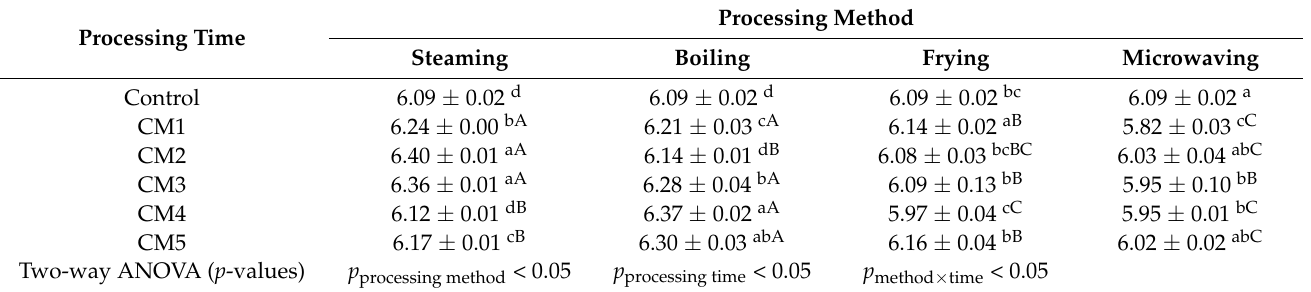
Table 2. Comparison of pH values of camel meat after different heat processing